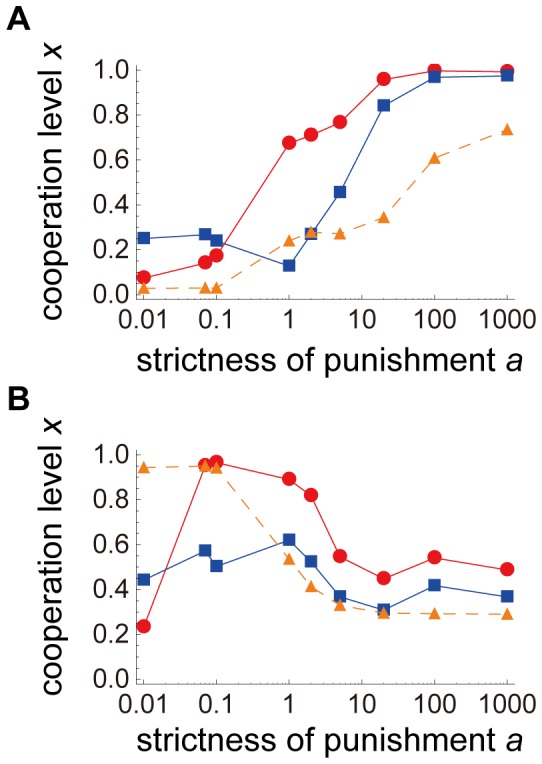
Evolution of cooperation level, punishment severity, and punishment threshold in the spatially structured condition.Values are averages of 50 trials at 1,000,000 generations. The horizontal and vertical axes represent log a and the value of each trait, respectively. The cooperation level (x) is denoted by a solid red line and points, the punishment severity (f) is denoted by an orange dotted line and triangles, and the punishment threshold (u) by a solid blue line and squares. The final level of cooperation with no punishment is 0.06272092 in the spatially structured condition and 0.03539616 in the random-matching condition. (A) presents the spatially structured condition and (B) the random-matching condition. The value of a used in this figure is 0.01, 0.07, 0.1, 1, 2, 5, 20, 100, and 1,000. When a = 0.0, (x, f, u) = (0.0747, 0.0327, 0.3223). The parameters are r = 3, β = 10.